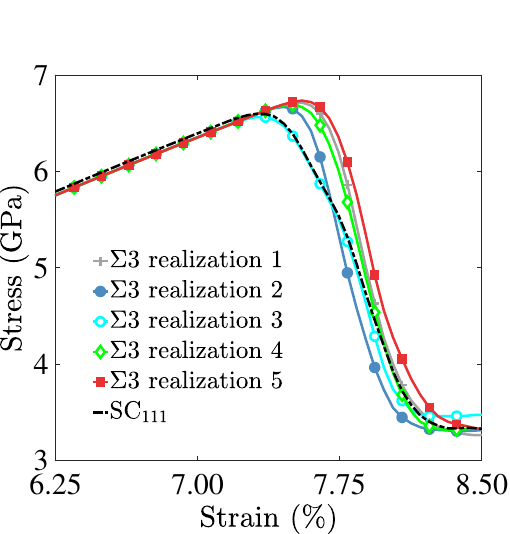
Figure 9. For the bicrystals with (a,b) [110] and (c,d) [111] STGBs, plots of the ultimate (a,c) stress and (b,d) strain as a function of the GBs present in these systems. Ultimate stress and strain values for Cantor alloy single crystals (dashed red lines) are also plotted for comparison.